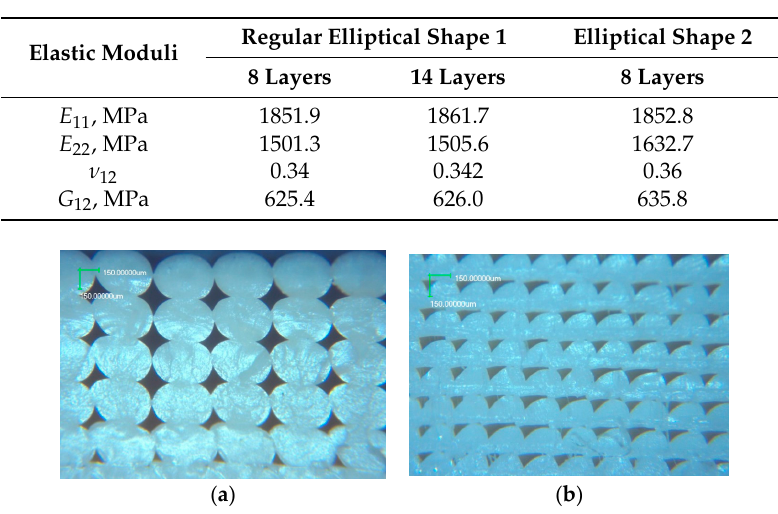
Table 4. Layer properties of the part processed by FDM for different mesostructures.